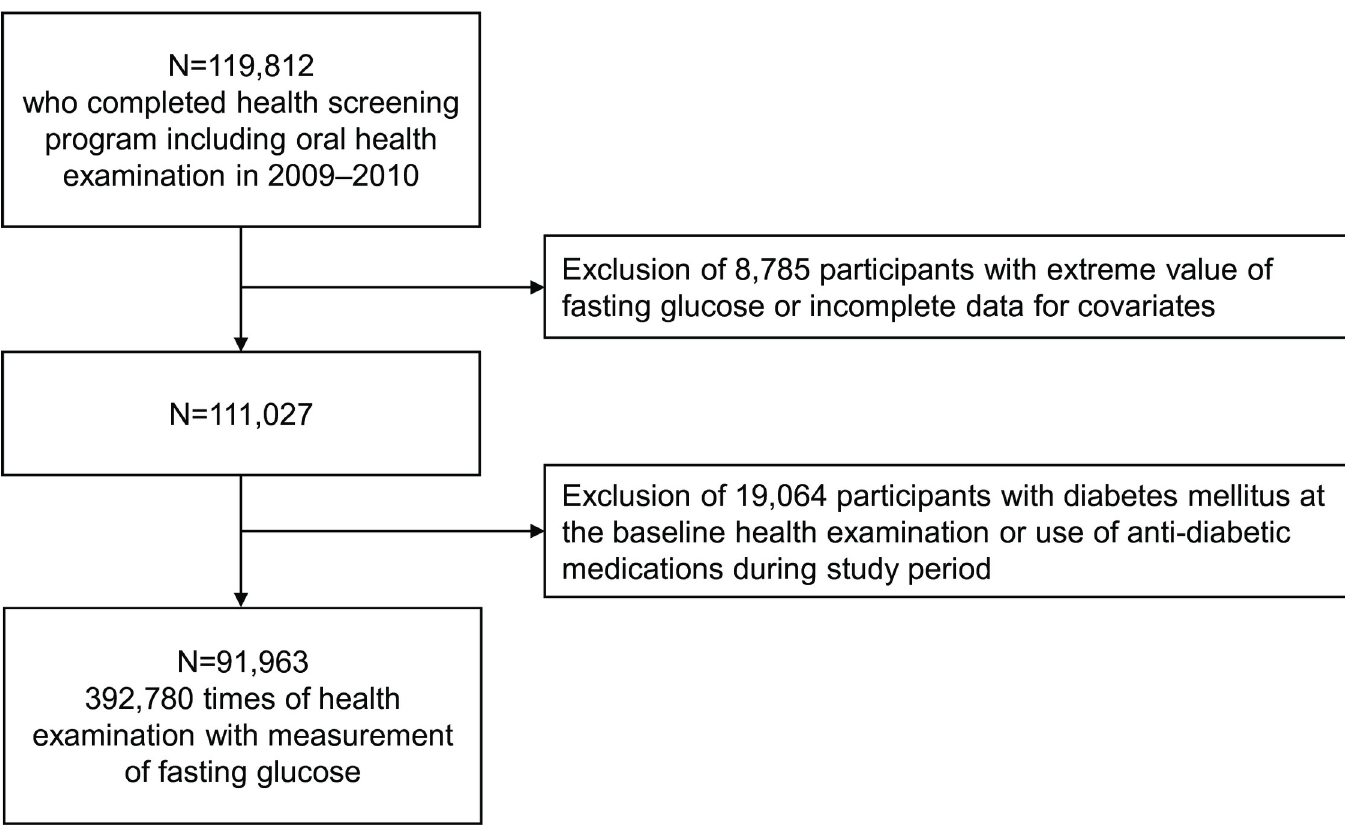
Fig 1. Flowchart of patient inclusion and